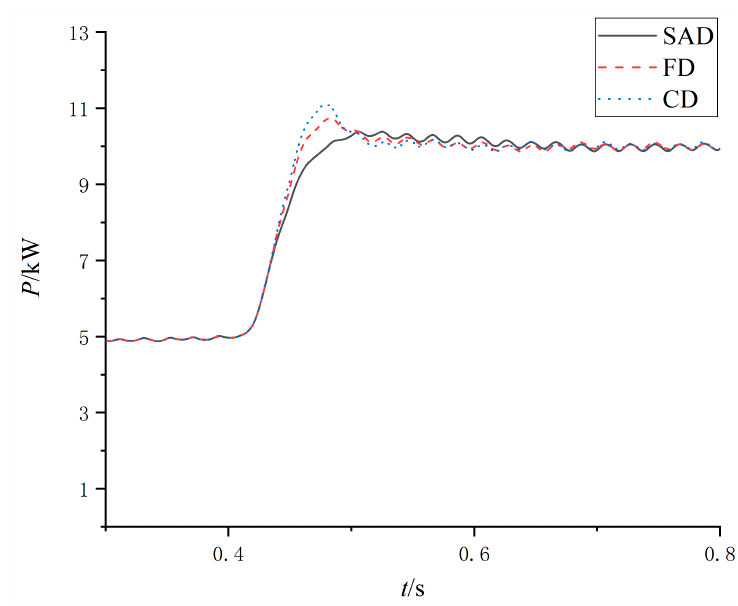
Figure 10. Output active power of VSG 1 under different damping control modes in grid-connected mode.